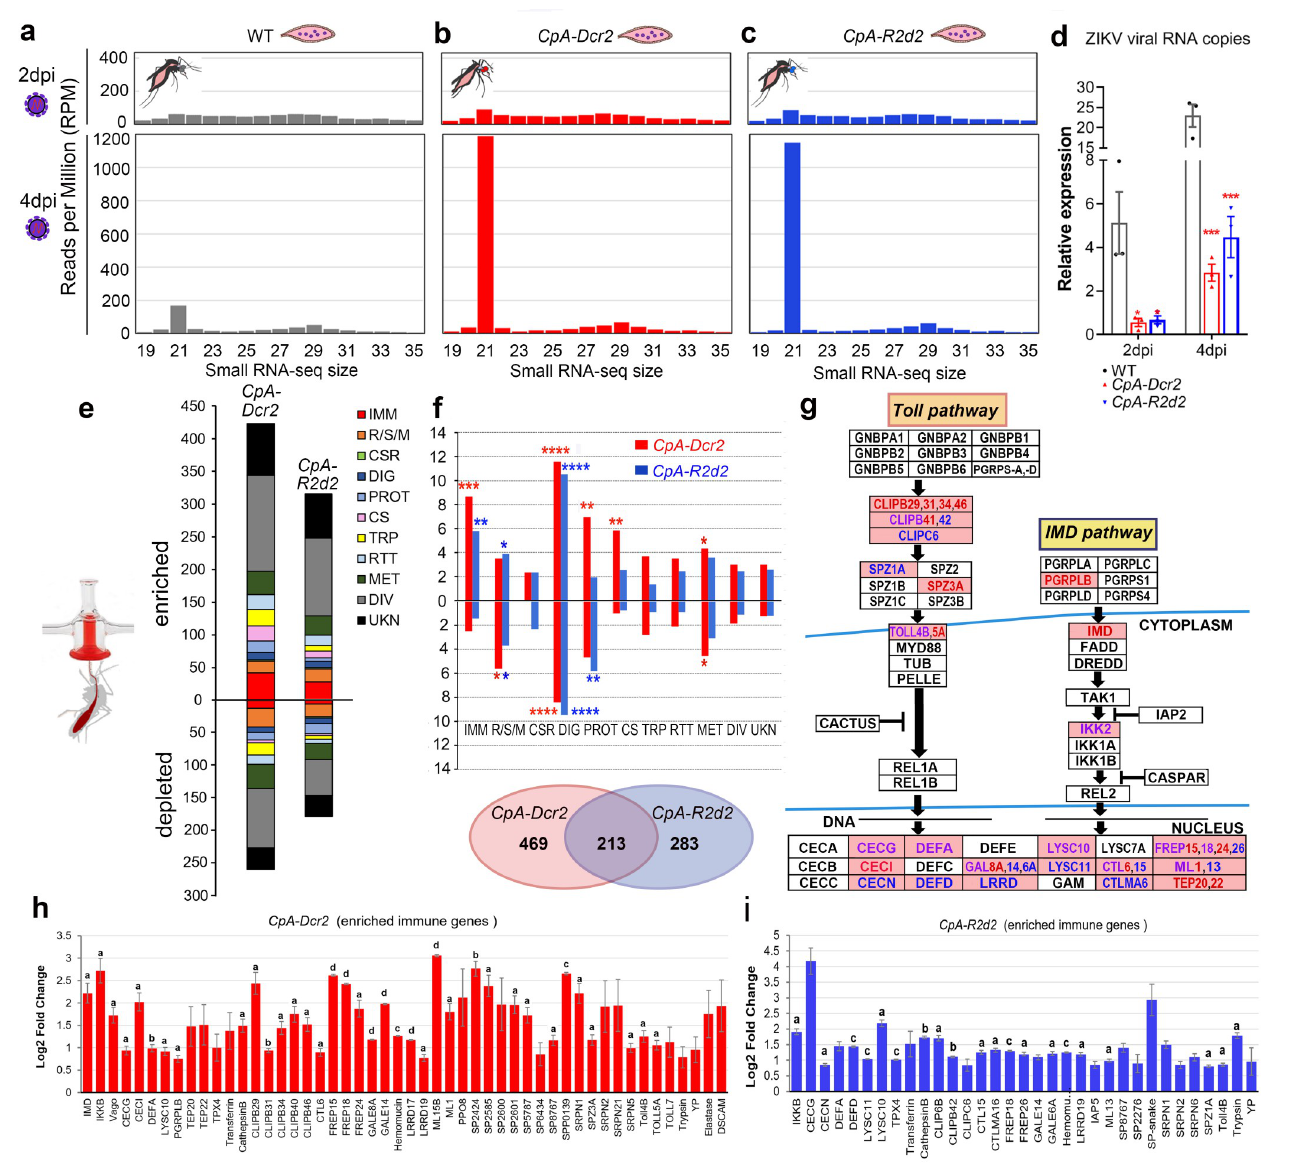
Fig 3. Production of ZIKV-derived siRNAs in infected WT and transgenic mosquitoes, and RNA-seq transcriptomic analysis of CpA-Dcr2 and CpA-R2d2 transgenic mosquitoes as compared to WT at 24 h PBM. ( a–c ) WT and transgenic ( CpA-Dcr2 and CpA-R2d2 ) mosquitoes were given a ZIKV-infected blood meal, and midgut samples were collected at 2 and 4 dpi for small RNA sequencing. Size distribution and 5 0 base frequency of ZIKV-derived small RNA sequences from 3 mosquito groups at 2 time points. ( d ) Relative expression of total ZIKV RNA, as a measure of viral load, in the control (WT), CpA-Dcr2 , and CpA-R2d2 midguts at 2 or 4 dpi. The AeRps7 gene was used as internal control with at least 3 biological replicates, the bar indicates the mean value +/ − SEM. ( e ) The number of DEGs within each FG between the midguts of transgenic and WT. ( f ) For each FG, the percentage of enriched or depleted transcripts in the midguts of transgenic lines as compared to WT. The total number of significant DEGs in both CpA-Dcr2 and CpA-R2d2 mosquitoes is shown in the Venn diagram. ( g ) Pathway analysis of both Toll and IMD pathways indicates immune genes in these pathways are strongly up-regulated. The boxes colored in pink represent genes up-regulated in either or both pathways, letters in red or blue or purple indicate genes up-regulated in CpA-Dcr2 or CpA-R2d2 , respectively, or in both transgenic lines. ( h and i) Log 2 -fold change in up-regulation of immune genes in either CpA-Dcr2 (h) or CpA-R2d2 (i) transgenic mosquitoes. Three biological replicates are given for each gene. The bar indicates the mean value +/ − SEM. a, P < 0.05; b, P < 0.01; c, P < 0.001; d, P < 0.0001. Detailed information of these up-regulated genes is listed in S3 Table. The illustration was created with BioRender.com. Data underlying this figure can be found in S2 Data. CS, cytoskeletal and structural; CSR, chemosensory reception; DEG, differentially expressed gene; DIV, diverse functions; DIG, digestive; dpi, days post- infection; FG, functional group; IMM, immunity; MET, metabolism; PBM, post-blood meal; PROT, proteolysis; RSM, redox/stress/mitochondrion; RTT, replication/transcription/ translation; TRP, transport; UKN, unknown functions; WT, wild type; ZIKV, Zika virus.